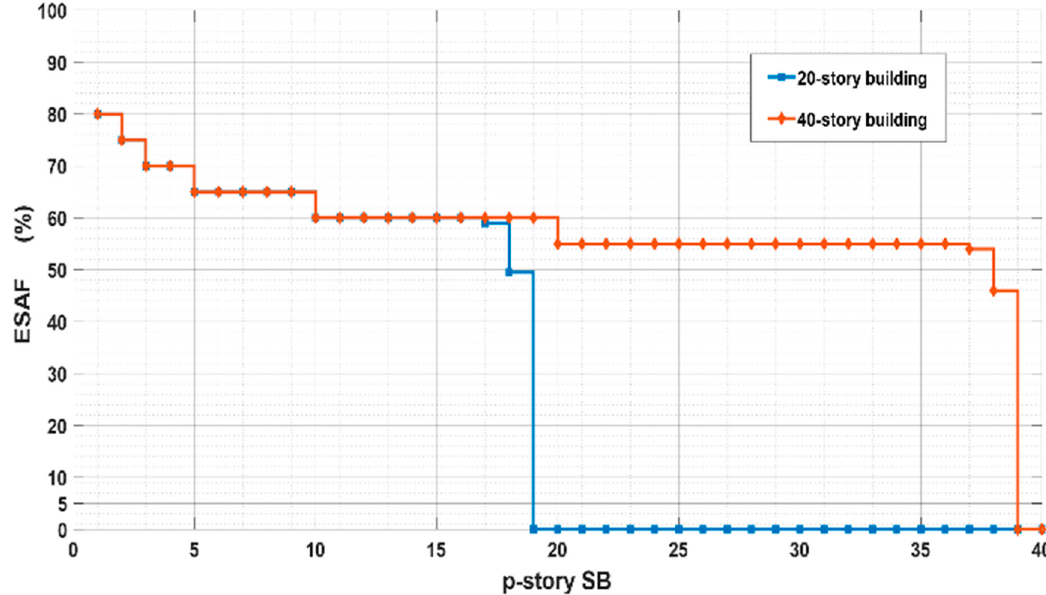
Figure 11. Effective Spectrum Availability per floor (ESAF) behavior for a 20-story SB and for a 40-story SB. d = 1 Km.